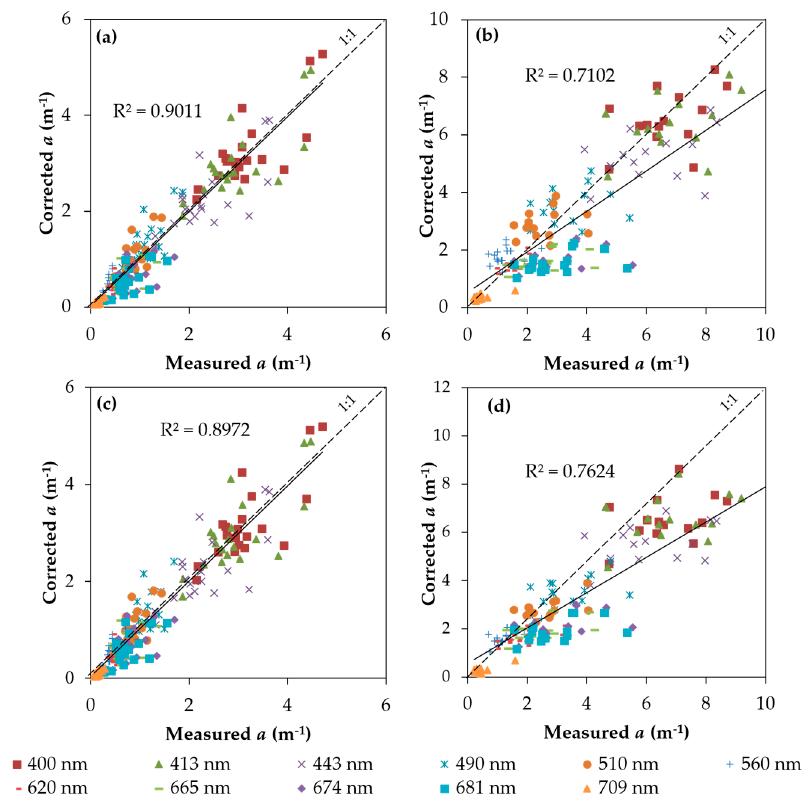
Figure 5. Measurements of a ( λ ) obtained by spectrophotometry in the laboratory and acquired by an ac-s meter, and previously corrected using the flat method applied to the ( a ) May and ( b ) October datasets, and using the proportional method applied to the ( c ) May and ( d ) October datasets.